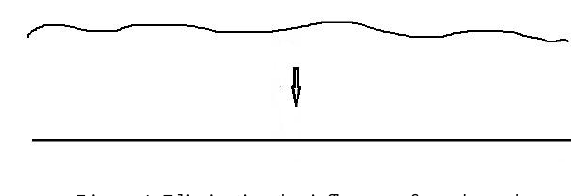
Figure 4. Eliminating the influence of rough